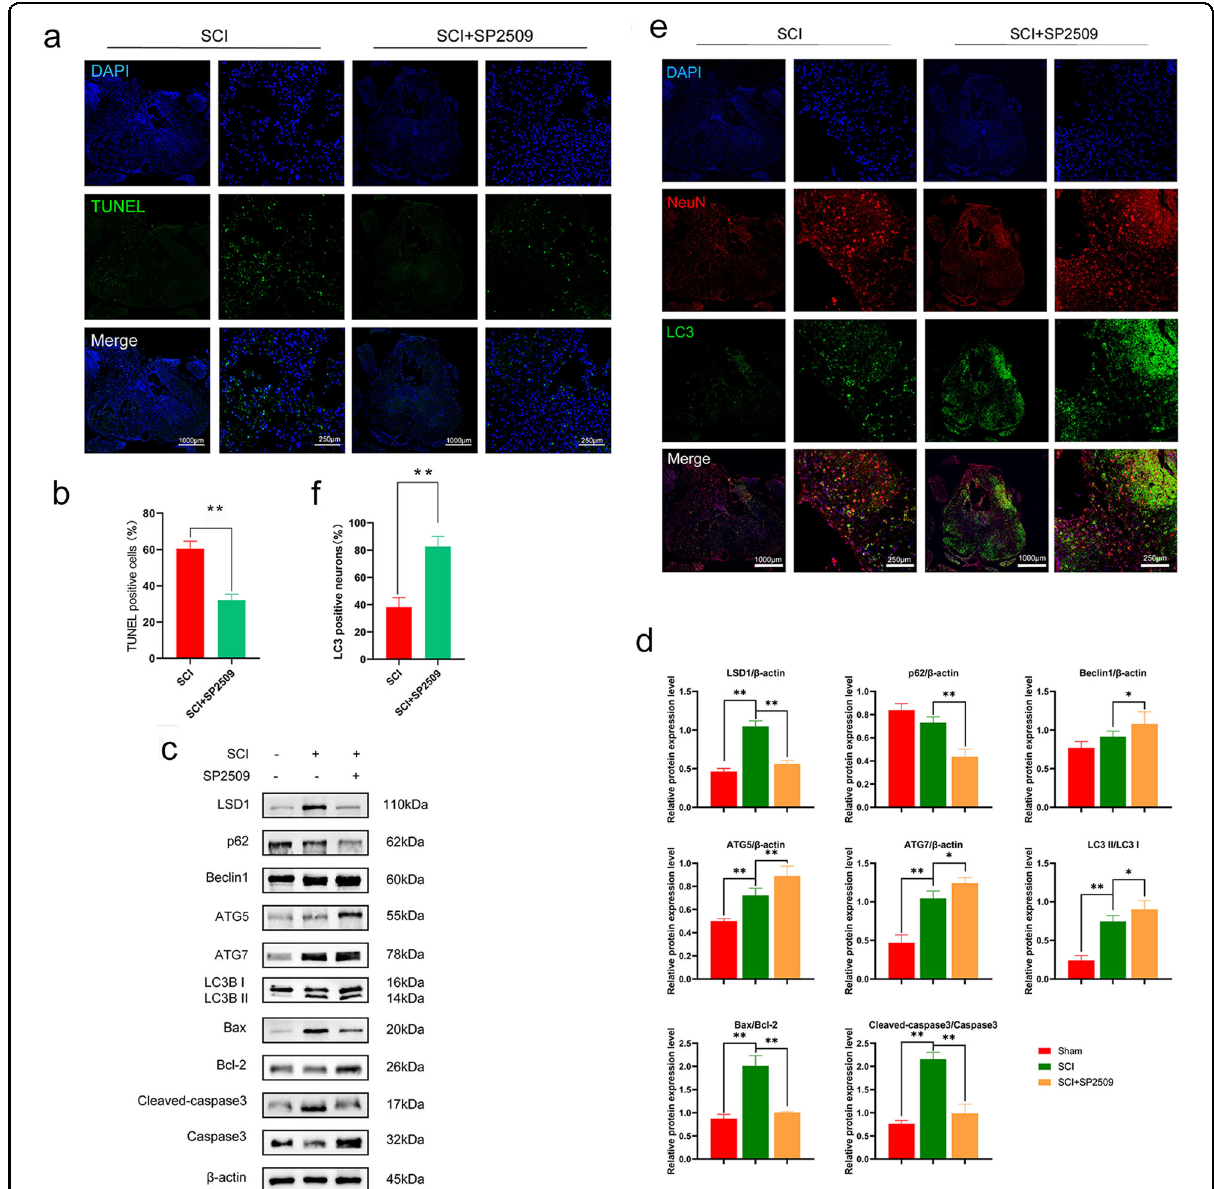
Fig. 2 Pharmacologically inhibiting LSD1 based on SP2509 enhanced autophagy and reduces apoptosis in spinal cord tissue. a Sample pictures of TUNEL-positive cells from the sham, SCI, and SCI + SP2509 groups at 1 week following injury. Scale bar = 1000 or 250 μ m. b Counting TUNEL-positive cells in slides. c Sample pictures depicting transverse spinal cord sections stained and a quantitative analysis with anti-LC3B and anti- NeuN antibodies in uninjured and injured rats with or without SP2509. DAPI (blue) was used to stain all cell nuclei. Scale bar = 1000 or 250 μ m. d Analysis of the amount of LC3 positive neurons in traumatic injury area. e LSD1 Western blot analysis, autophagy, and apoptosis proteins following injury. f Semi-quantitative determination of autophagy and apoptosis protein levels. One-way ANOVA and Tukey ’ s multiple comparisons test was used to compute p values for mean ± SD of three independent experiments. * p < 0.05; ** p <